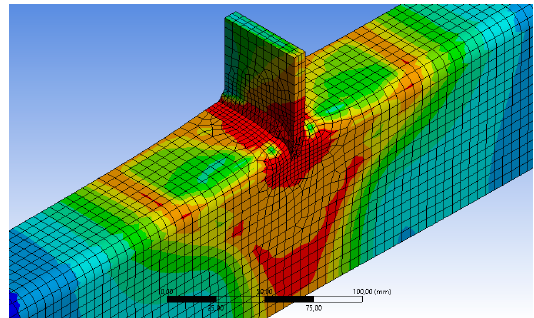
Figure 7. FEA model .